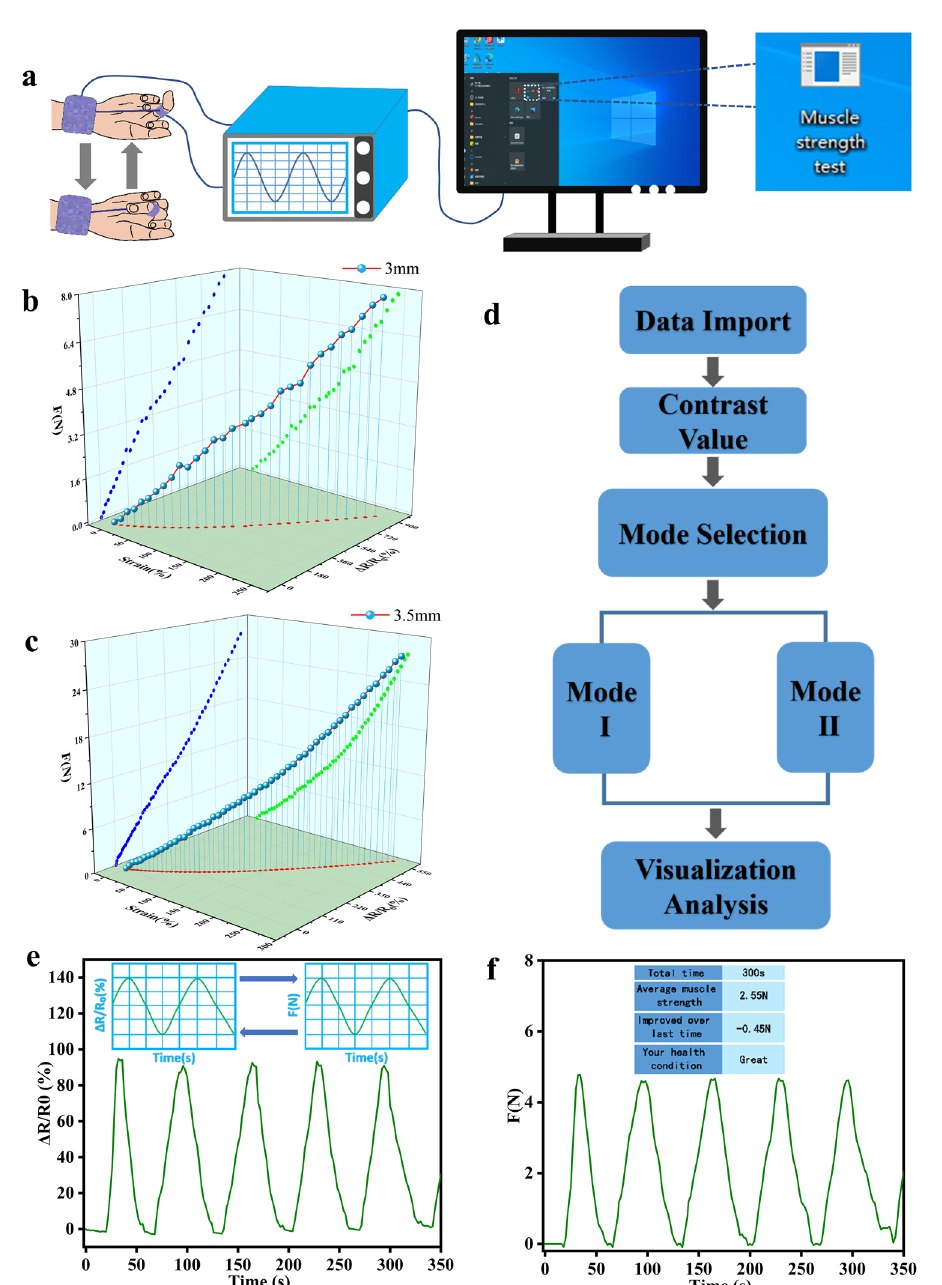
Fig. 7 PGC sensor for finger joint muscle training. a Diagram of the training-analysis process. b , c Force-stress-resistance three-dimensional curve and resistance real-time change curve for 3/3.5 mm type sensor. d Flow chart of the operation of MST analysis software. Tester’s resist- ance rate of e change-time, f traction force–time